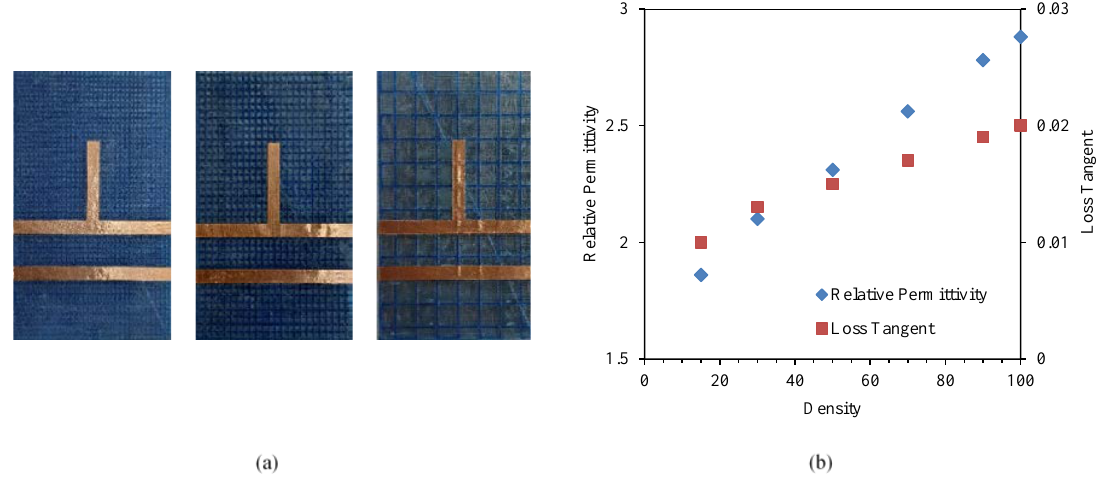
Figure 5. ( a ) Resonator and transmission line for PLA with 70%, 50% and 15% densities. ( b ) Electrical characteristics for different filling densities of the PLA substrate.